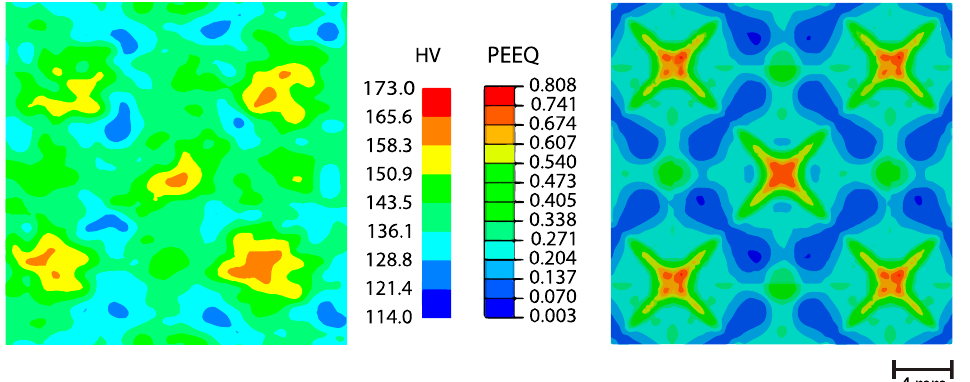
Figure 6. Comparison between hardness distribution and equivalent plastic strain for one-cycle condition. This hardness distribution result shows the highly deformed zone in the sample.